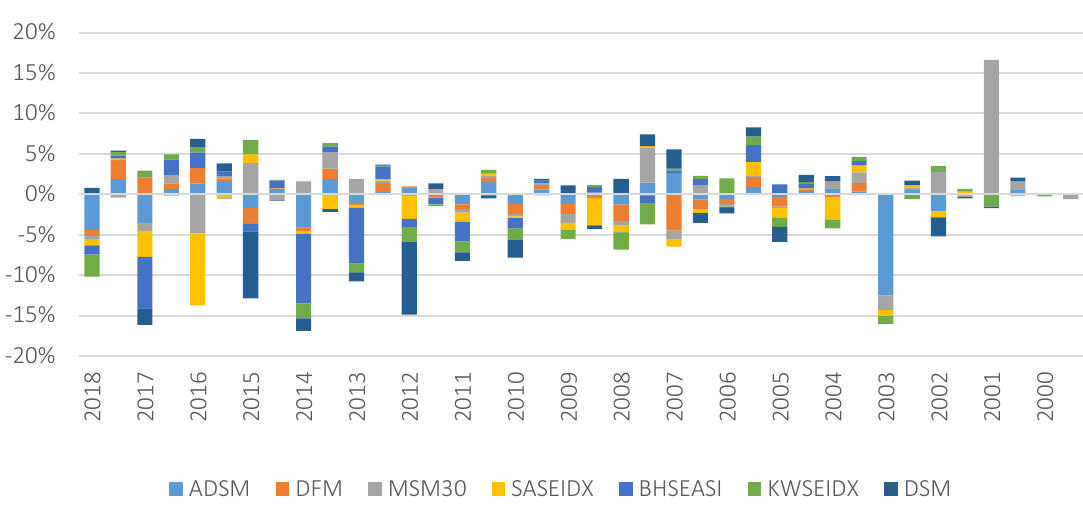
Figure 1. GCC market performance for the period 2000–2018